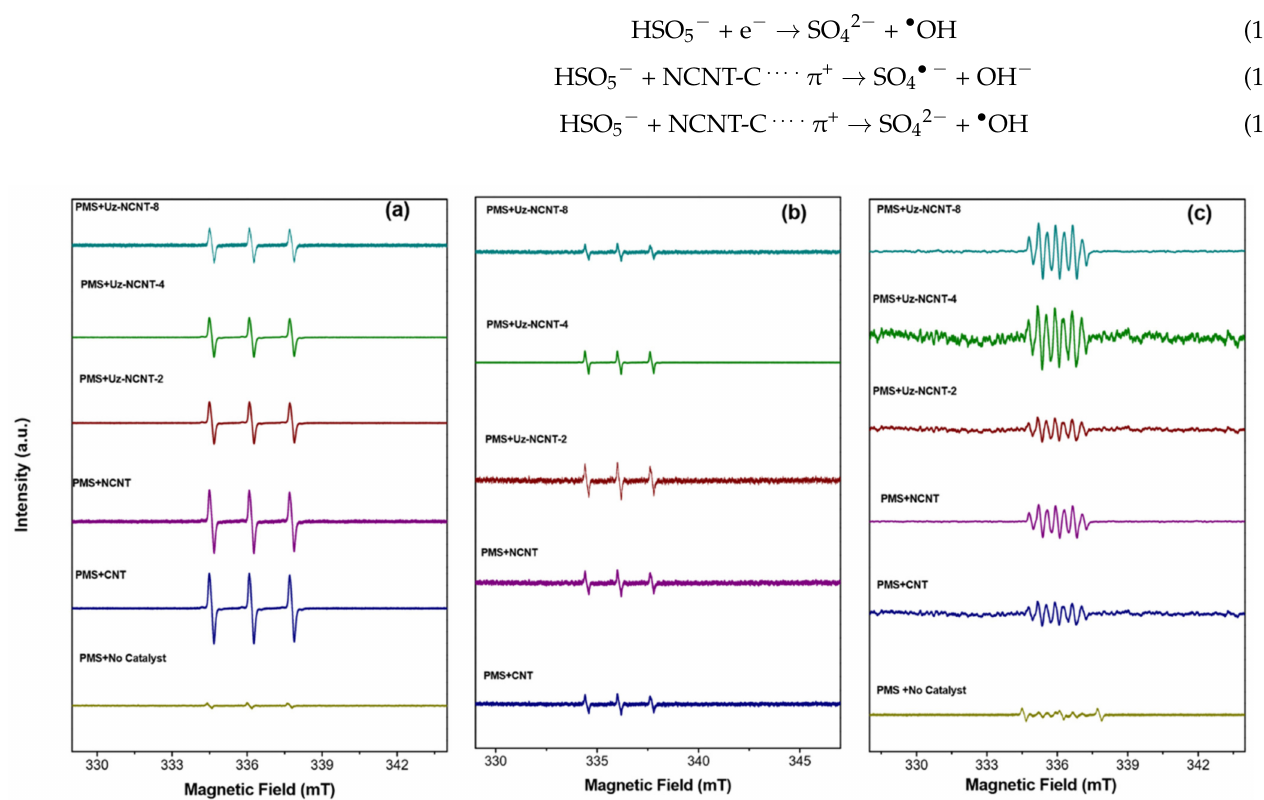
Figure 4. ( a ) EPR spectra of TMP- 1 O 2 adducts under different carbocatalyst/PMS systems. ( b ) EPR spectra of TMP- 1 O 2 analyzed in the presence of C FFA = 10 mM, and C TMP = 50